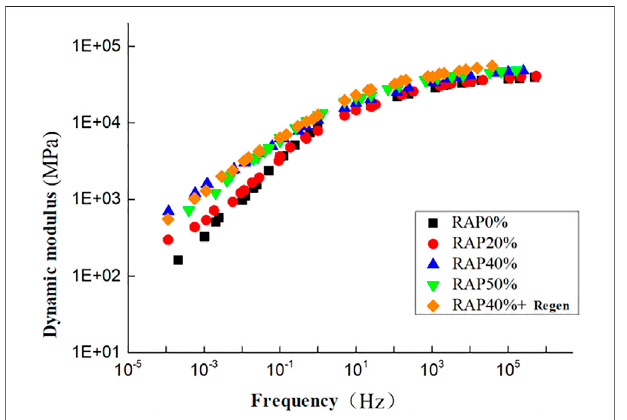
FIGURE 3 | Master curve of fi ve different AC-13 modi fi ed asphalt recycled